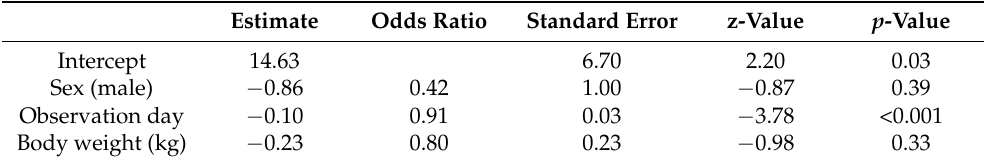
Table 4. Results of the logistic regression model for defaecation.